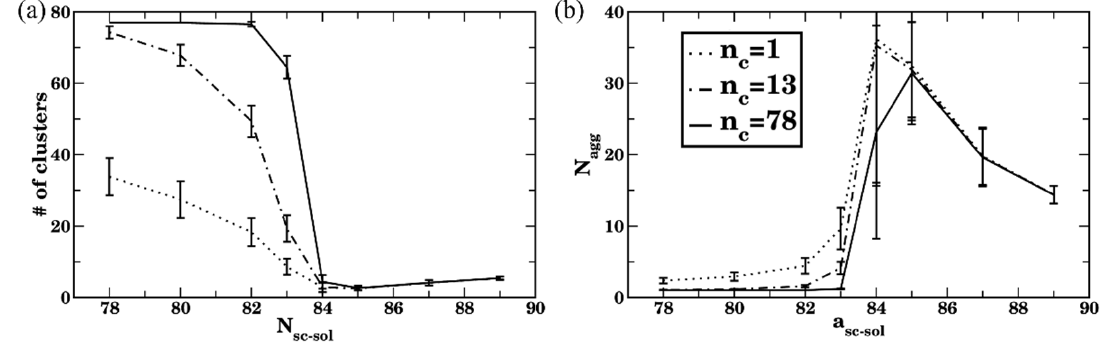
Figure 7. Late time average of ( a ) number of clusters and ( b ) aggregation number for sidechain length N sc = 6. Dotted, dash-dotted, and solid lines of the same color represent the number of contacts used to identify clusters (n c = 1, 13, and 78, respectively). The data are averaged over n MBB = 77 bottlebrushes in four independent simulation sets for each time step, the error bars represent standard deviation.